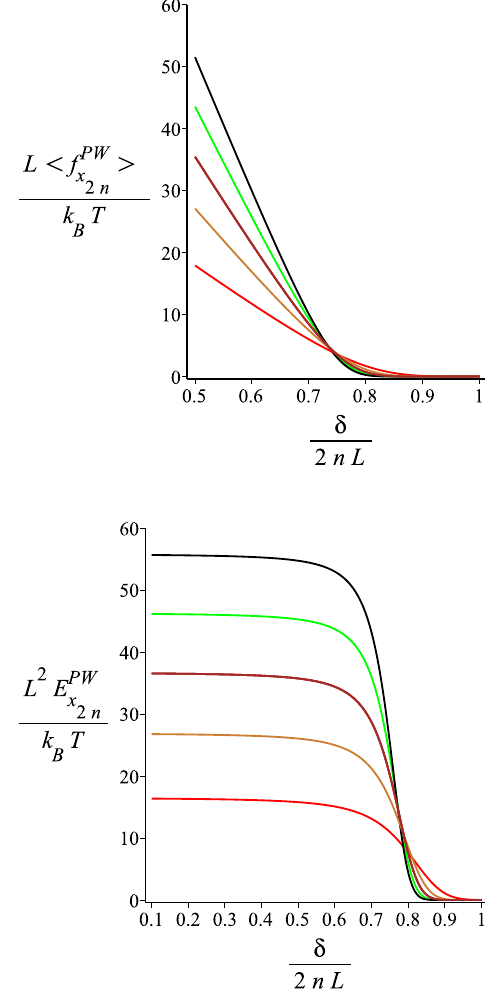
Figure 17. The first panel : The dimensionless force of the structure with an even number of arms exerted on the confining wall as a function of the dimensionless distance of the wall from the grafting point. The second panel : The dimensionless differential stiffness of the system with an even number of arms as a function of the dimensionless distance of the wall from the grafting point. The red, gold, brown, green, and black are associated with the fixed values of the single-arm bending stiffness = 12.5 i , where i = 1,2,3,4,5, respectively. The other fixed parameters are: ω = π parameter l p L φ µ = 0, φ B = 0 n = 2, and K B =